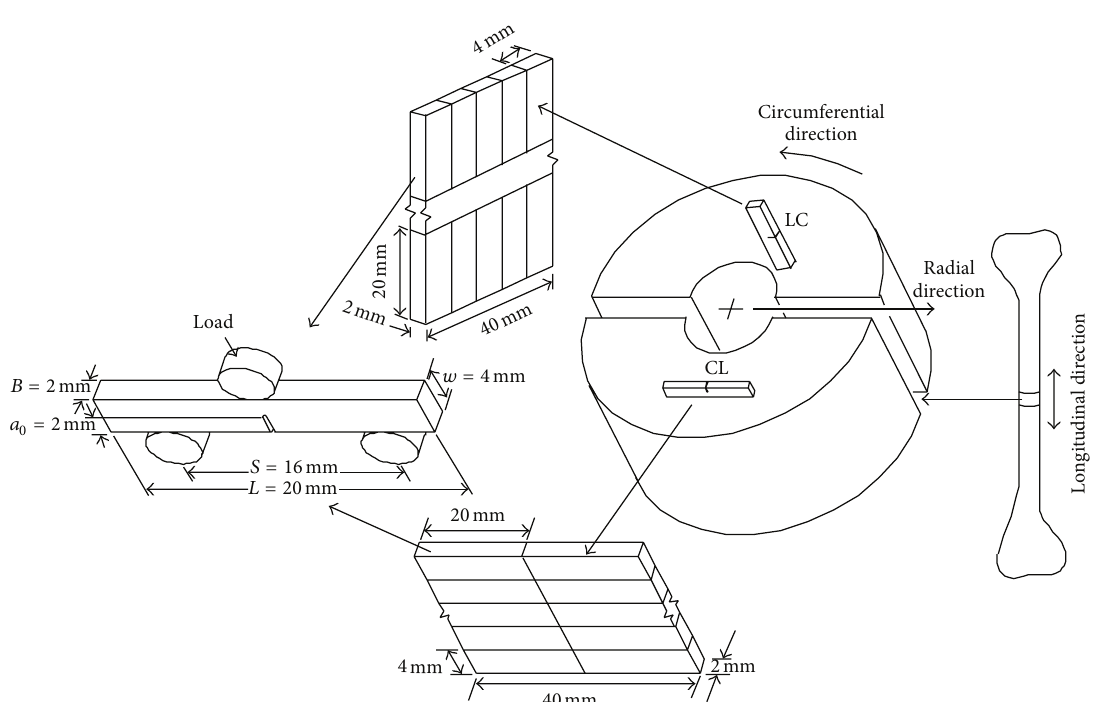
Figure 1: Preparation of 3-pt bend specimen in two directions: circumferential-longitudinal (CL) and longitudinal-circumferential (LC), where the first letter of the specimen name refers to the normal direction of the created crack plane and the second letter refers to the expected direction of crack